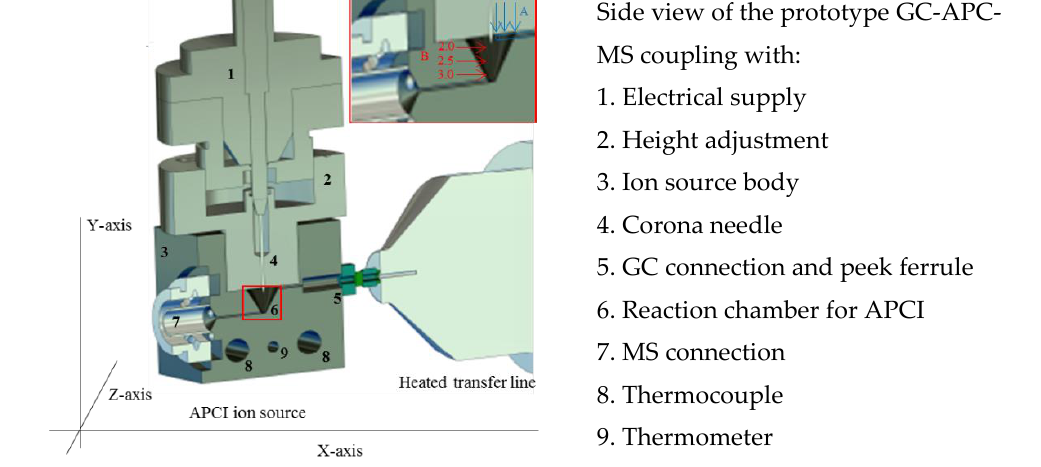
Figure 2. Drawing of the new GC-APCI-MS ion source design and coupling. For the optimization of the column position, the distance between the column and ion source body was set to 0, 2, and 4 mm. This is seen by arrows A. At 0 mm, the column outlet and the ion source wall are at the same hight. Arrow B shows the variation of the corona needle in the y -axis, which is given in a distance between the closing plane of the needle holder of the ion source chamber and the tip of the needle.